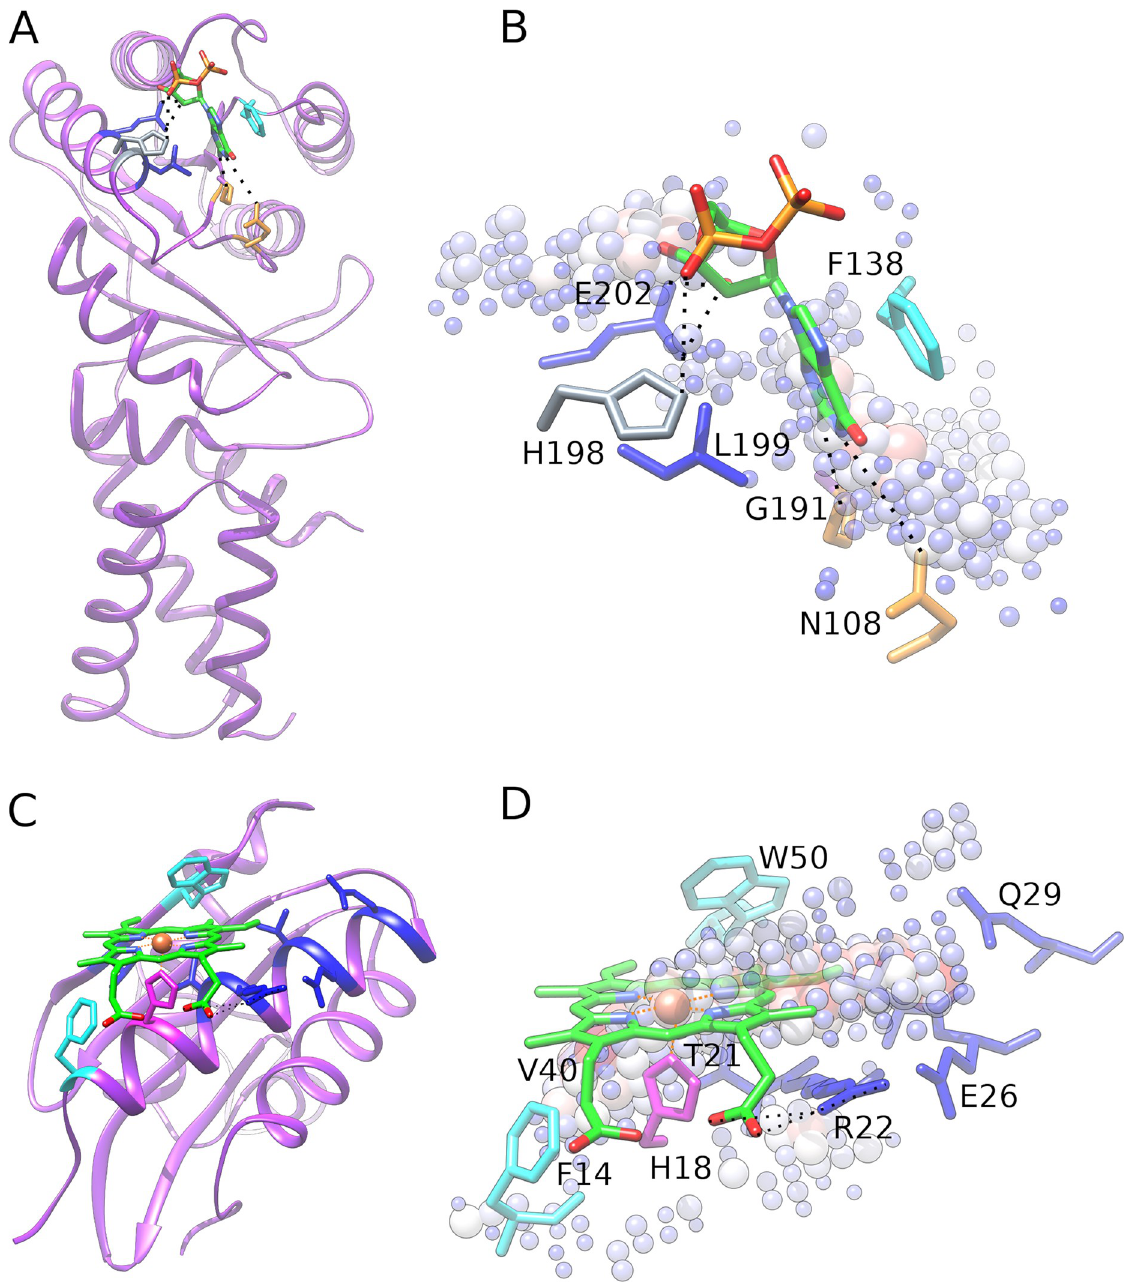
Fig 8. Two examples of accurately classified ligand-binding pockets. ( A and B ) A GDP-binding protein, the signal recognition particle receptor ftsY from E . coli , and ( C and D ) a heme-binding protein, the C-terminal domain of the S . enterica PduO protein. ( A and C ) Experimental complex structures and ( B and D ) close-ups of binding sites with high-scoring class-activation map (CAM) grid points. GDP and heme are shown as green sticks colored by atom type (C–green, O–red, N–blue, P and Fe–orange), whereas grid points are represented by spheres whose size and color depend on CAM values according to the scale shown in Fig 3. Hydrogen bonds are indicated by dashed black lines. Selected binding residues are labeled and colored by the interaction type (hydrogen bond–orange, aromatic–gray, hydrophobic– blue, aromatic and hydrophobic–cyan, hydrogen bond, aromatic and